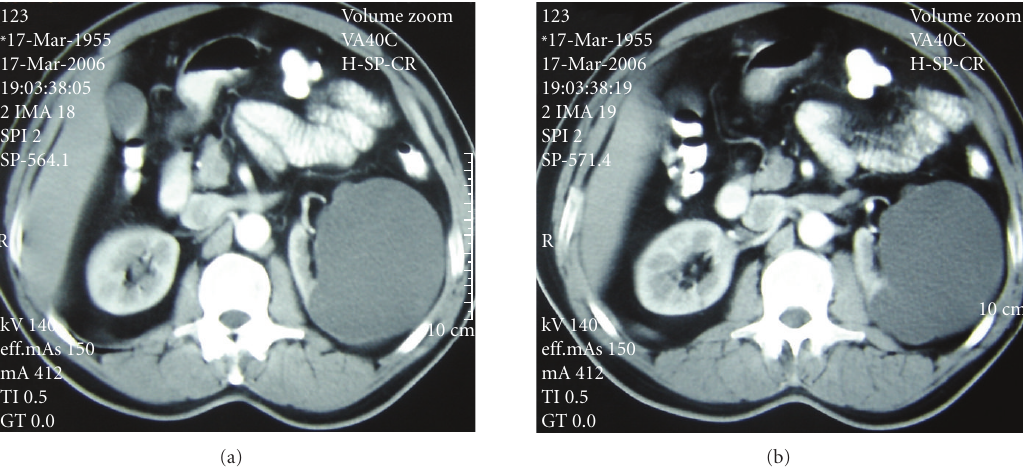
Figure 4: Left simple renal cyst before treatment.